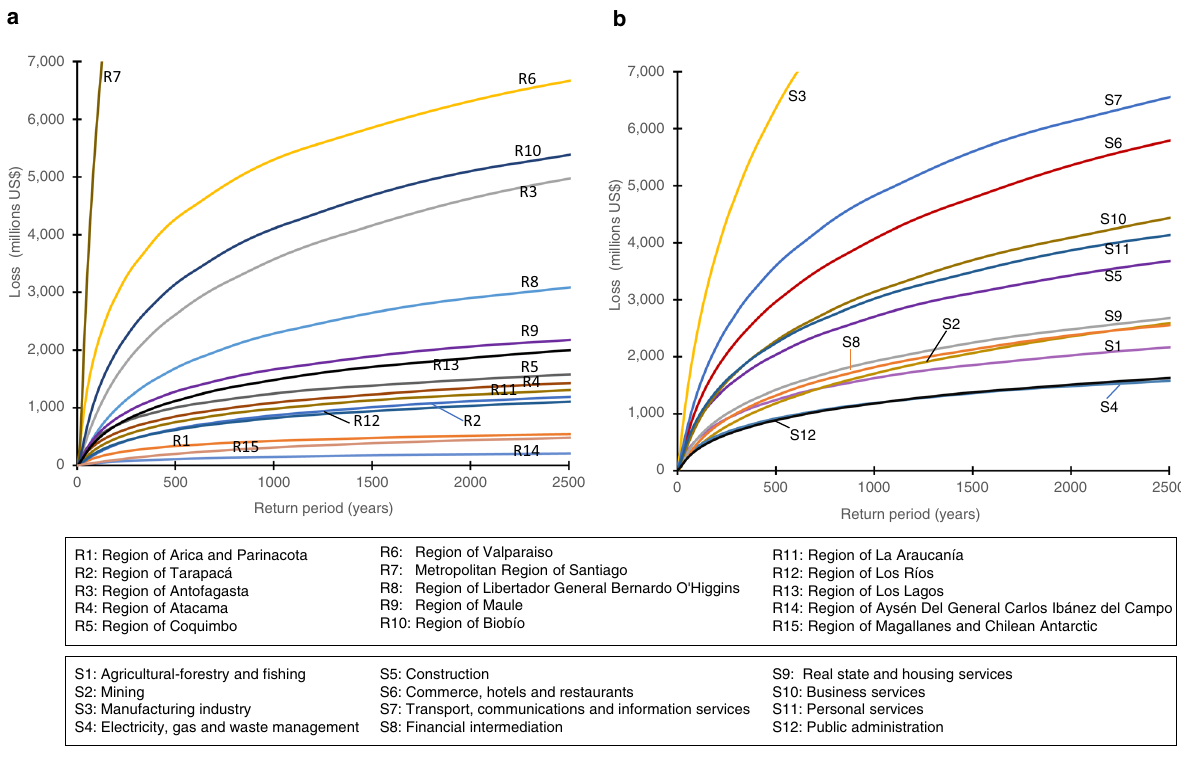
Fig. 4 Loss Exceedance Curves (LECs) of Chilean production by region. a By region of the country, ( b ) by economic sector. Note that LEC is presented with the return period (the inverse of the exceedance rate) in the horizontal axis and the loss values in the vertical